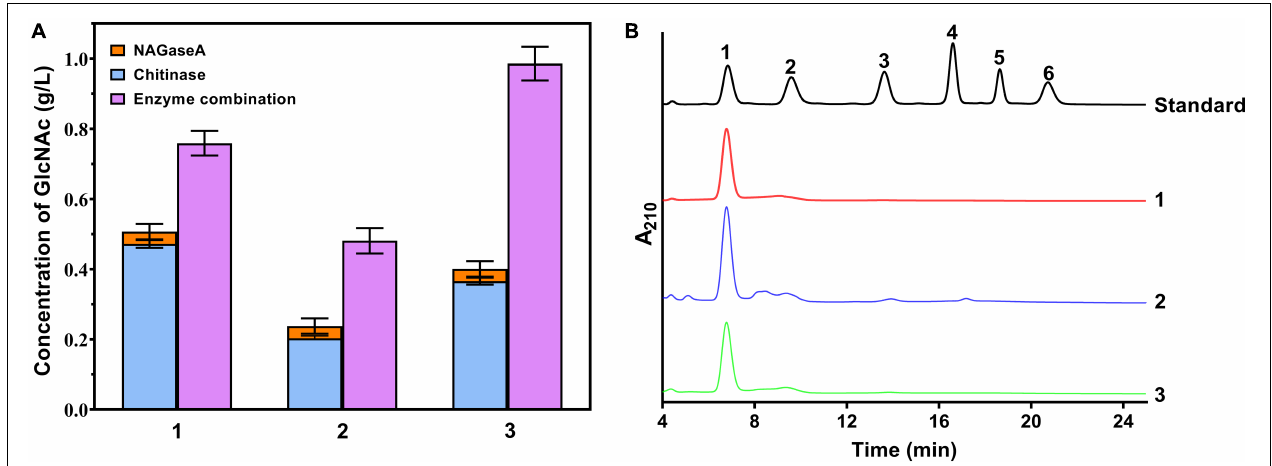
FIGURE 5 | Production GlcNAc from chitin using cocktail enzyme. (A) Effect of cooperative interaction between NAGaseA with chitinases on the hydrolysis of chitin. 1: cooperation of NAGaseA with purified chitinase chiA; 1: cooperation of NAGaseA with purified chitinase chiA; 2: cooperation of NAGaseA with crude enzyme from C. meiyuanensis SYBC-H1; and 3: cooperation of NAGaseA with crude enzyme from Chitinibacter sp . GC72. (B) HPLC analysis of the finial products of reaction